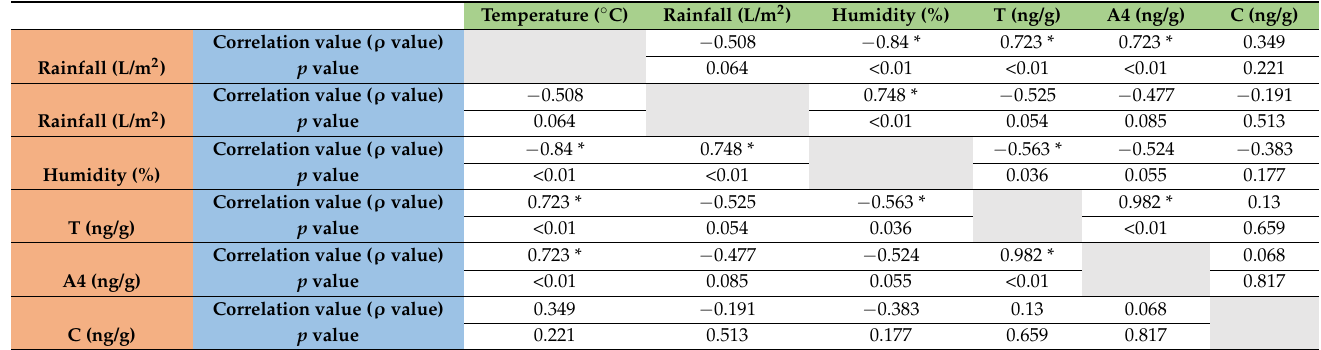
Figure 1. Correlations between T (blue bars) and climatic variables [temperature (purple), rainfall (green) and humidity (red)] during the period of study. A discontinuous line represents independence of the variable. Table 4. Spearman correlation coefficients between the variables of the study [temperature (°C), rainfall (L/m2), humidity (%), testosterone (T) (ng/g), androstenedione (A4) (ng/g), and cortisol (C) (ng/g)] (N = 14).